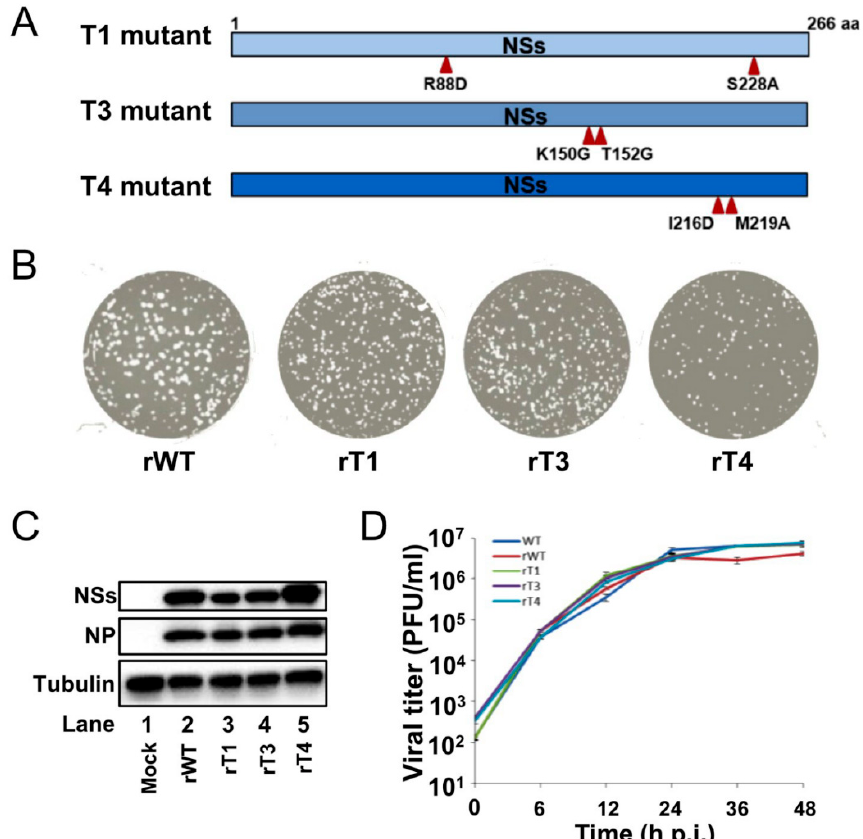
Figure 3. Rescue of recombinant RVFVs with mutations that affect the NSs filament formation. ( A ) Schematic representations of NSs mutations introduced into the reverse genetics system. ( B ) Plaque assay of rWT and mutant viruses on Vero cells. Plaques were stained with crystal violet at 7 days p.i. ( C ) Western blot analysis of infected cells. Huh7 cells were infected with rWT and mutant viruses at an MOI of 1, and cell lysates were harvested and analyzed at 24 h p.i. with indicated antibodies. ( D ) Replication kinetics of WT, rWT and mutant viruses in Huh7 cells. Huh7 cells were infected with respective viruses with an MOI of 0.1 and the supernatants were collected at 0, 6, 12, 24, 36 and 48 h p.i. Viral titers were detected by plaque assay on Vero cells; error bars represent standard deviation.